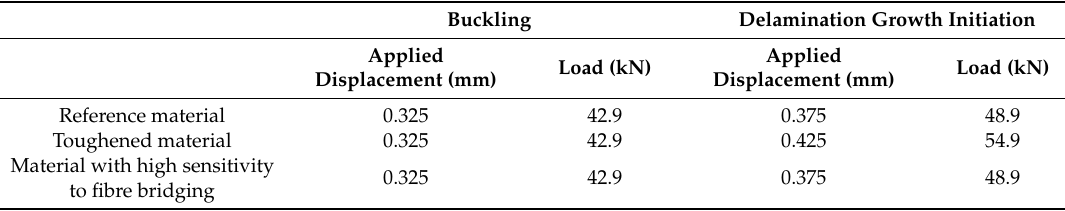
Table 2. Delamination onset and buckling load (SMXB).